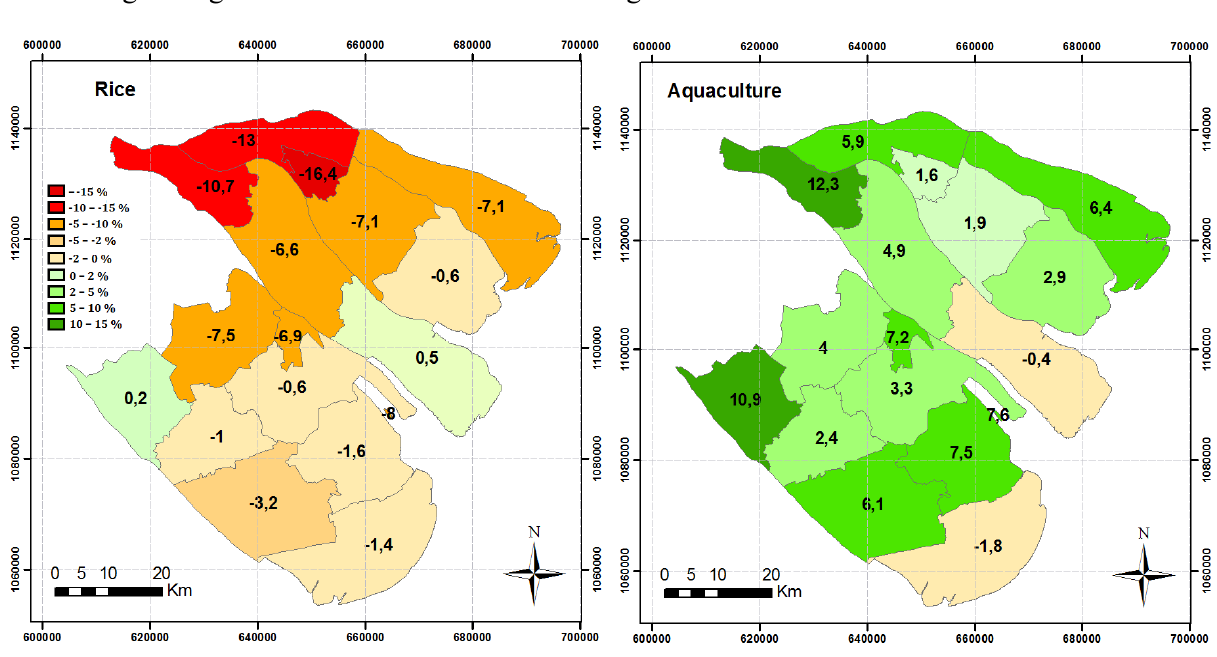
Figure 5. The relative change (%) in acreage of rice cultivation ( Left ) and aquaculture ( Right ) based on the SAR classification results. The red color denotes the decrease in acreage and green denotes the increase in